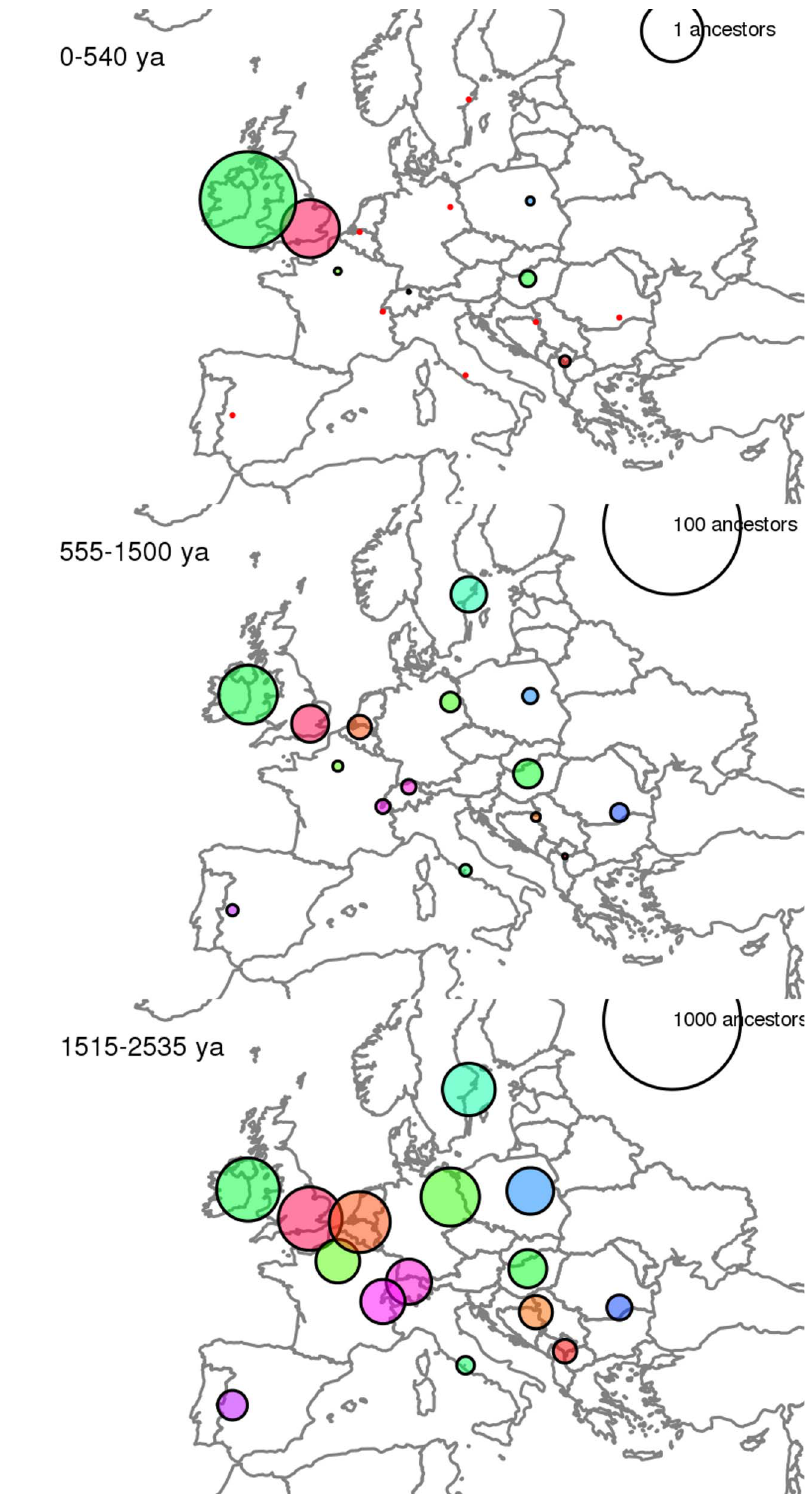
The distribution of distant cousins of modern-day people in the UK, at three different levels of geneological distance (circle size proportional to numbers of cousins; units are numbers of shared ancestors). Image credit: Peter Ralph and Graham Coop.